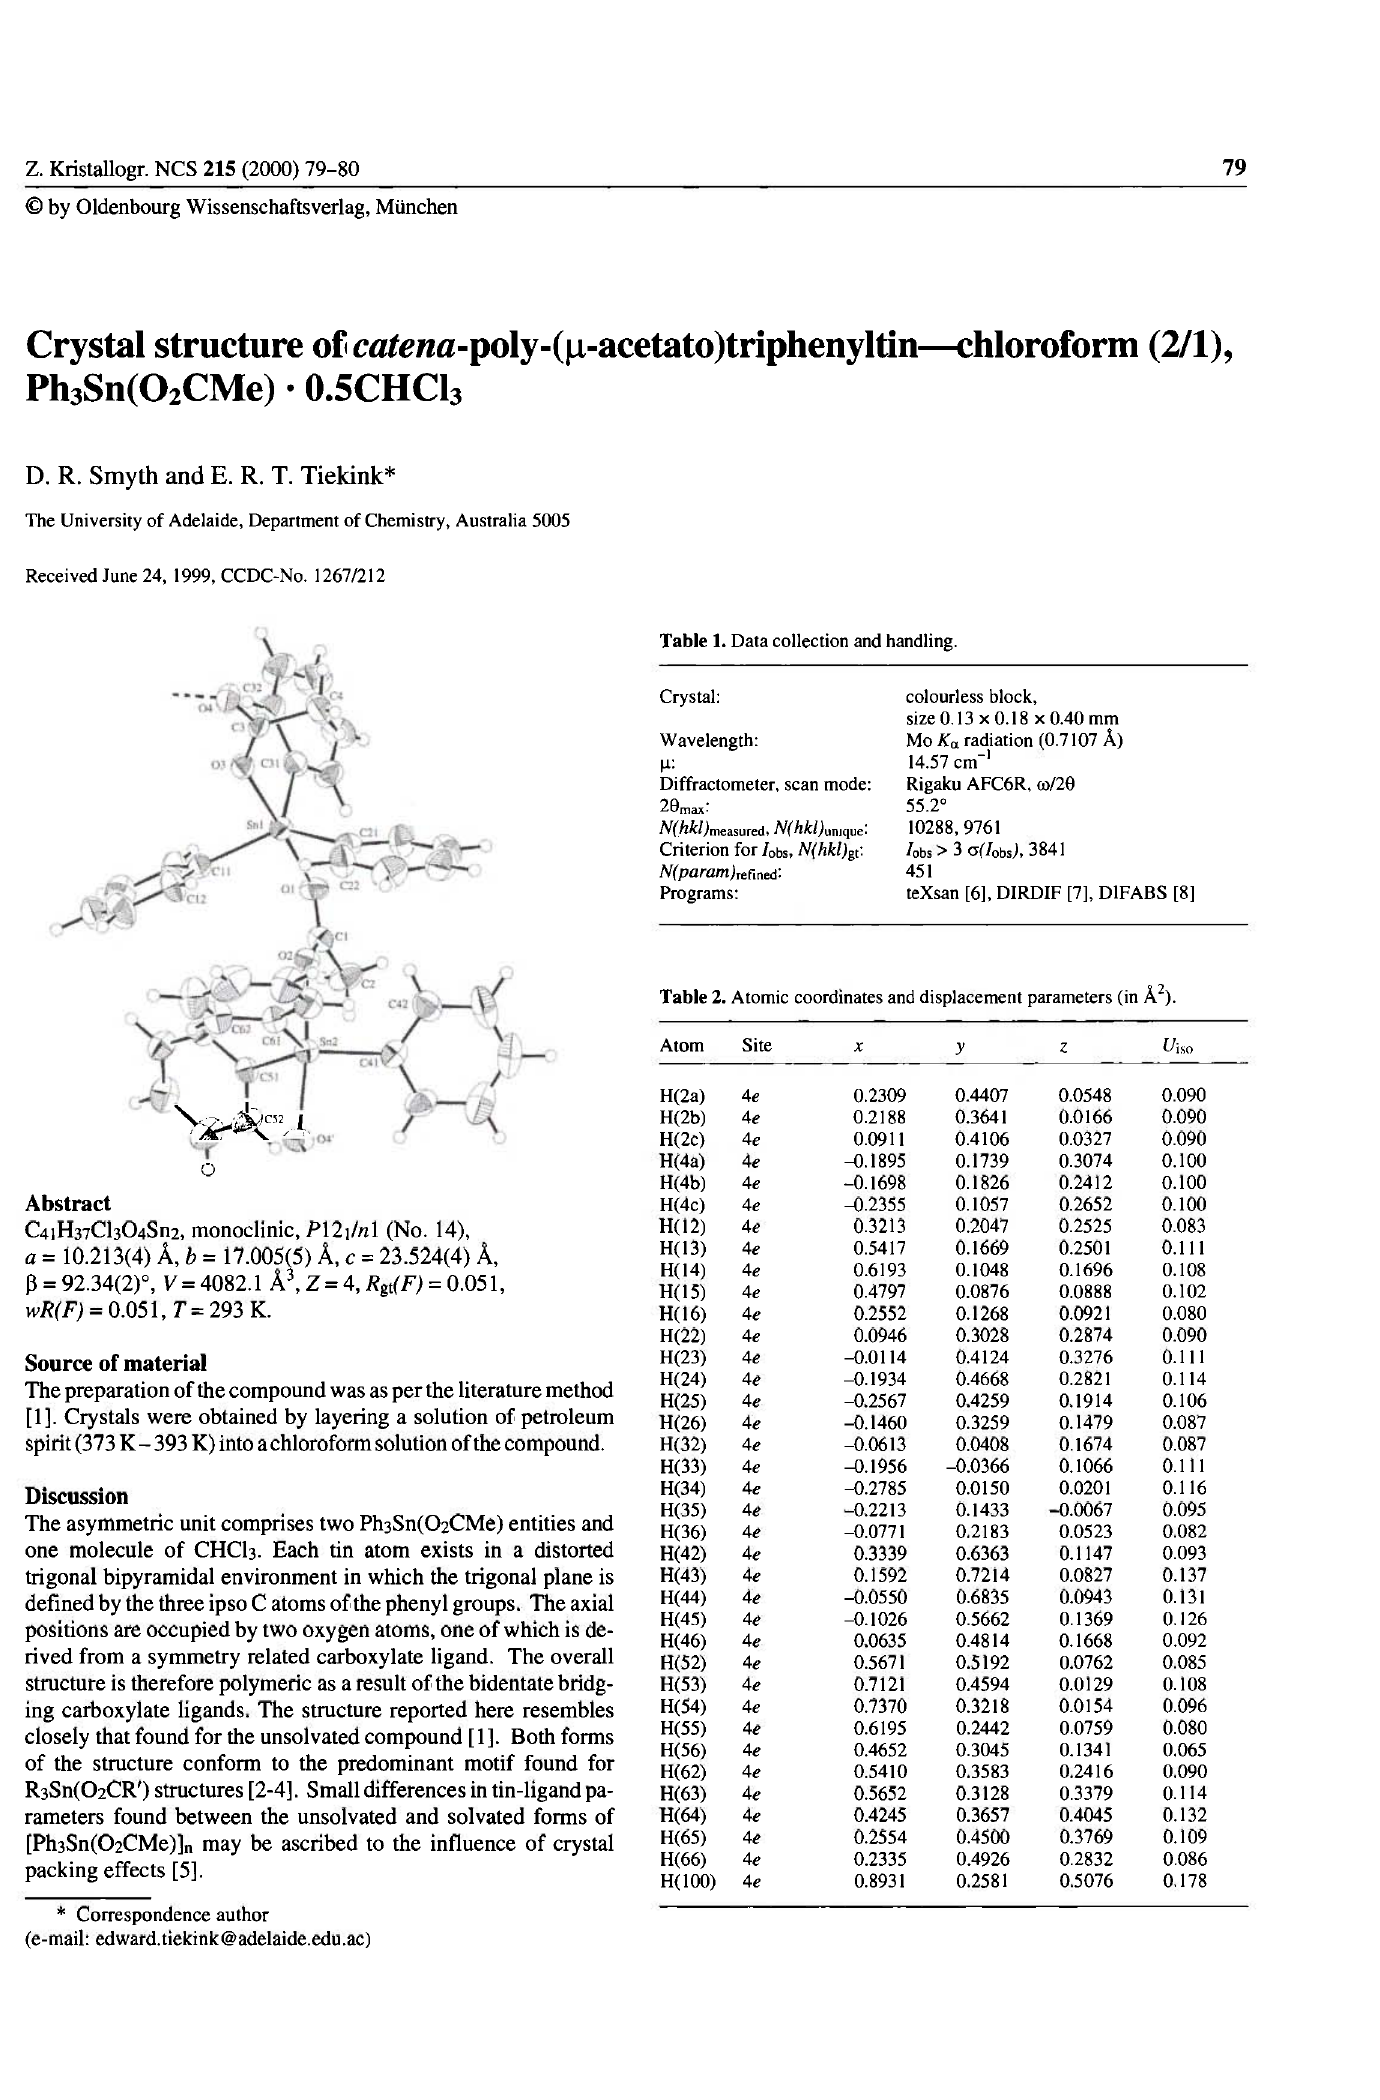
Table 2. Atomic coordinates and displacement parameters (in Ä 2